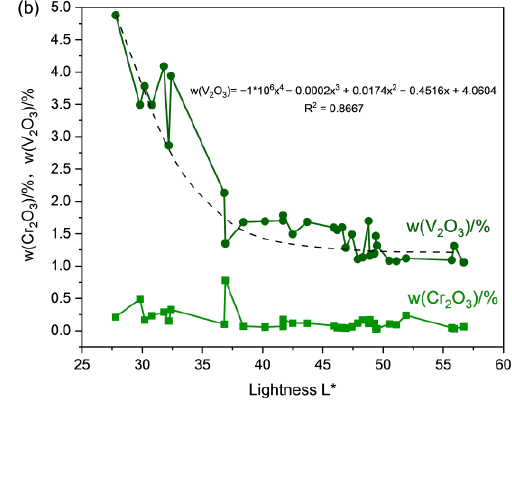
Table 2. The clustering accuracy corresponding to different clustering numbers.